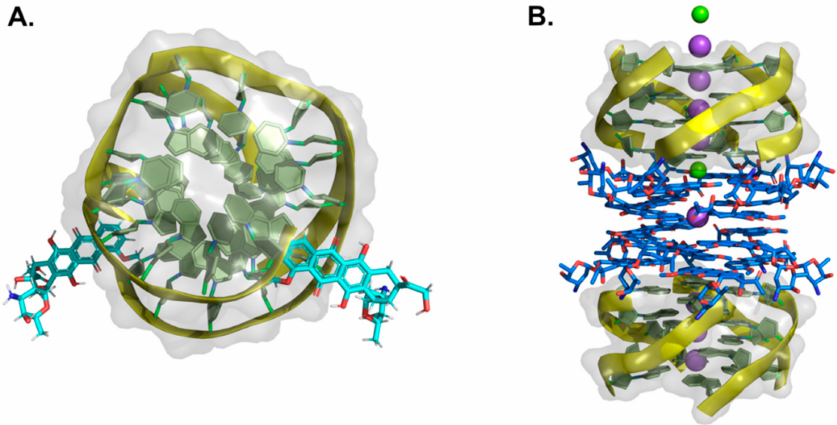
Figure 9. Structural representation of the human telomeric G4 (cartoon and transparent surface) in complex with ( A ) adriamycin (6KN4) and ( B ) daunomycin (3TVB) (represented as colored